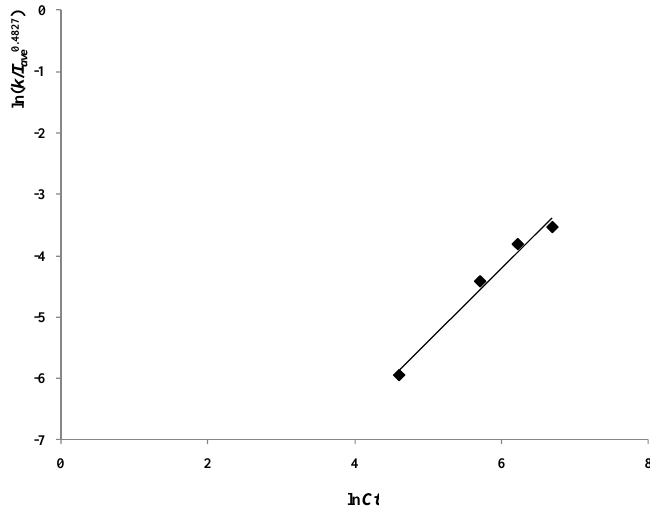
= 20 mg/L, S = 400 0 L